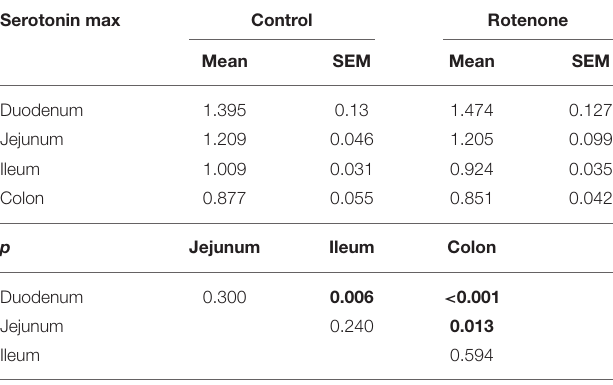
TABLE 8 | Shows the mean values (mean) and the standard error of the mean (SEM) for the muscle tone (Min.) by serotonin (S) when added in the presence